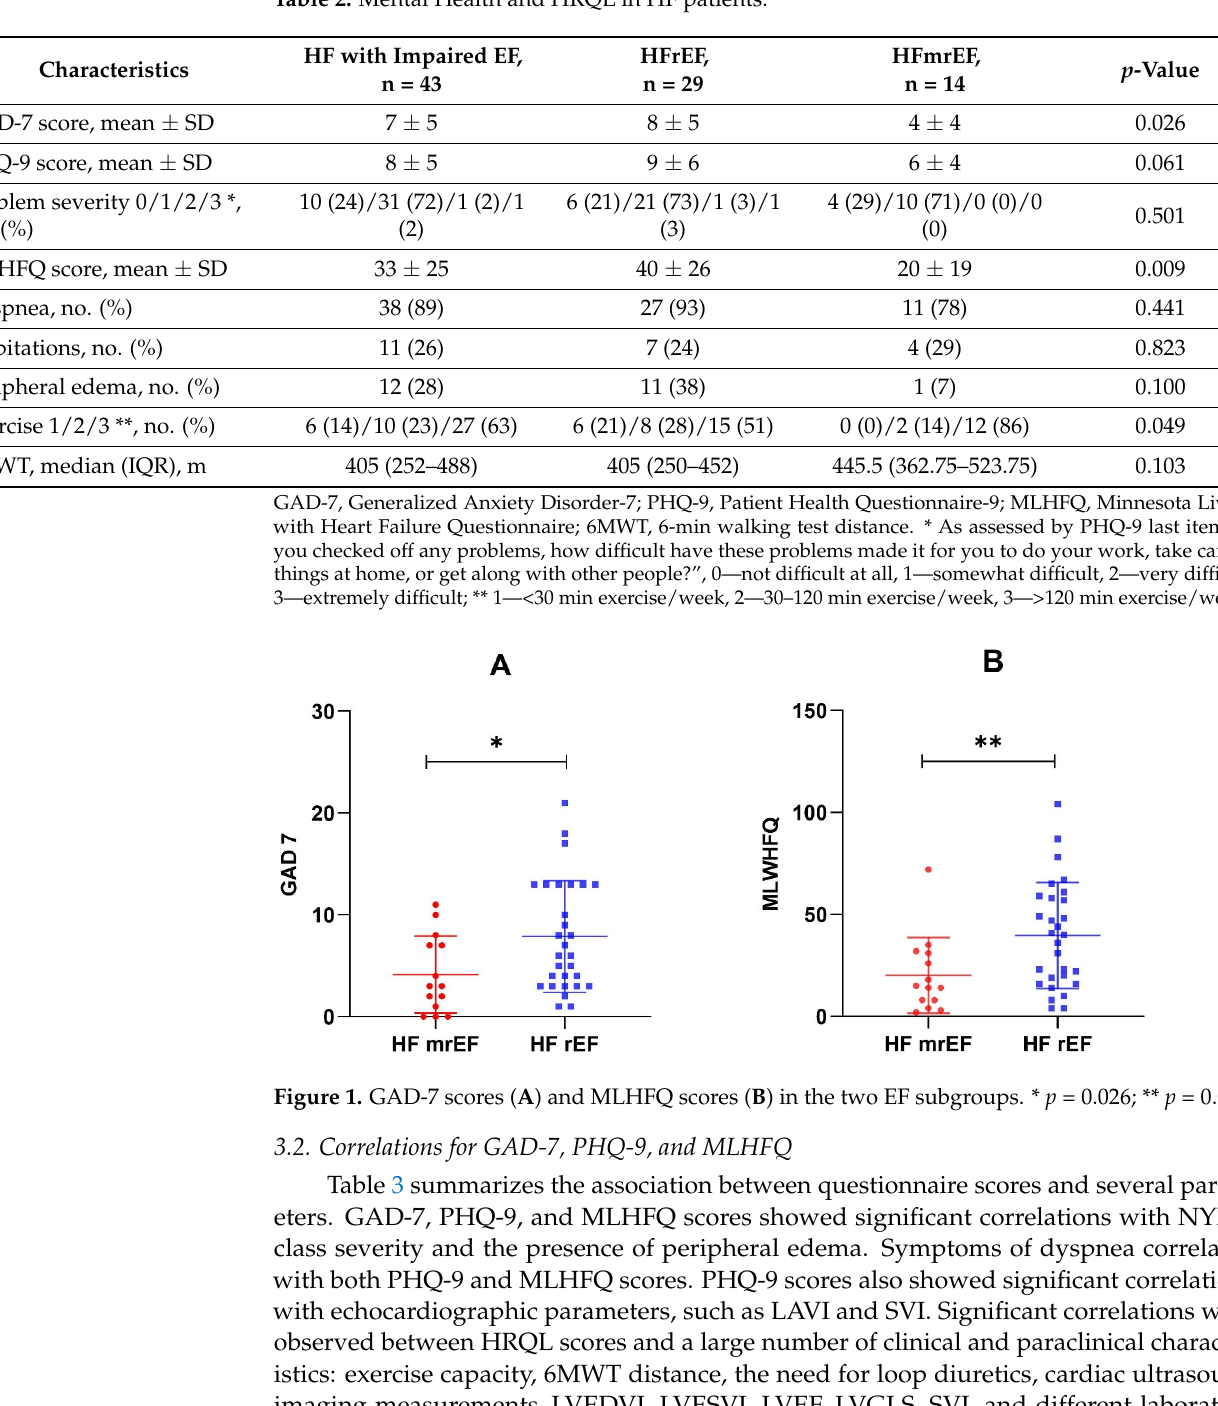
Table 3. Correlations for GAD-7, PHQ-9, and MLHFQ scores in the overall group (n = 43) .